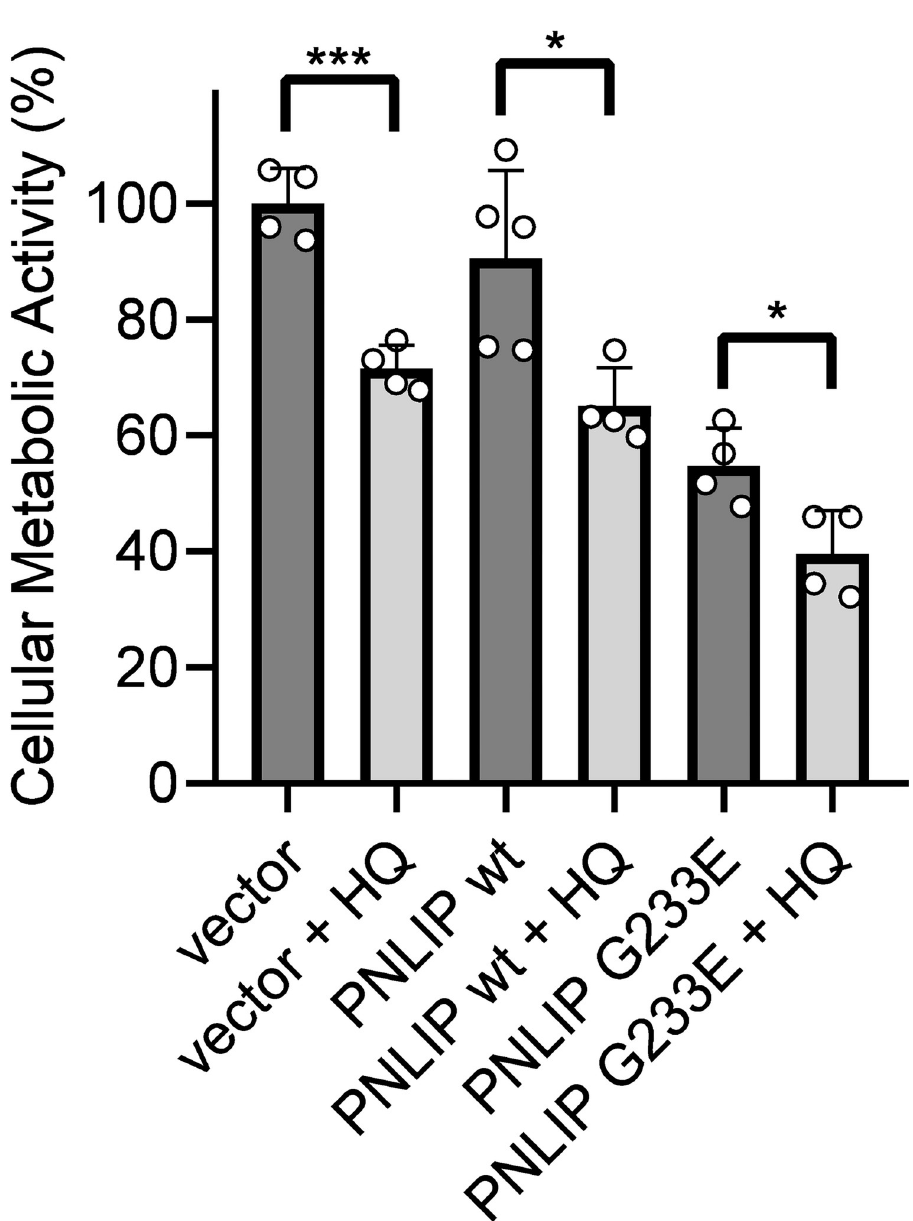
Fig 7. Effect of hydroquinone (HQ) on the viability of wild-type and G233E mutant PNLIP expressing AR42J cells. One day post-transduction, cells were incubated in the absence or presence of 40 μ M HQ for 24 h at 37 ˚C, and the levels of cellular metabolic activity were analyzed by MTT assay as described in Materials and Methods. Cells transfected with empty adenovirus vector were used as control. Data points represent the average of four independent experiments with SD. � P � 0.05; ��� P �